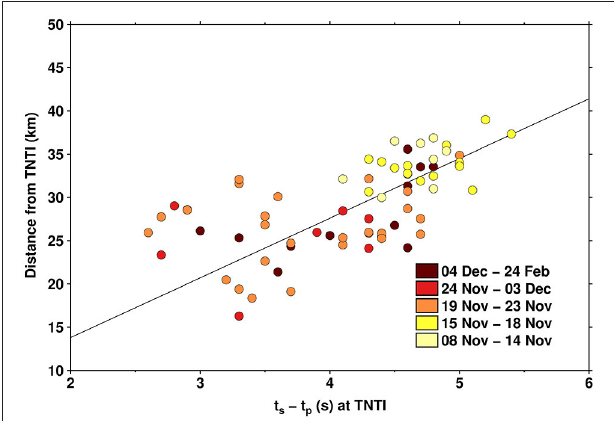
FIGURE 4 | Manually picked t S -t P times plotted against the epicentral distance from TNTI station for the 69 events of the swarm well-relocated using the regional seismic network. Color code is the time from November 2015 – February 2016 as in Figure 3 . The decrease of the t S -t P differential times during the most active swarm period (8–23 November) in the seismic signals recorded at TNTI station is compatible with southward migration of the seismicity. The scatter is likely due to the fact that we neglect the hypocentral depths to calculate the distances. The best-fitting regression line with slope v a = 6.8 km/s is